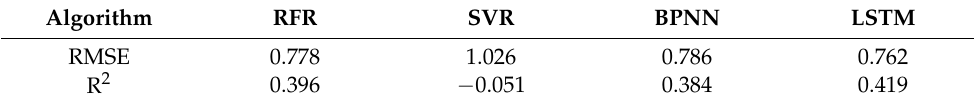
Table 2. Forecasting index of each algorithm on strongly disturbed time